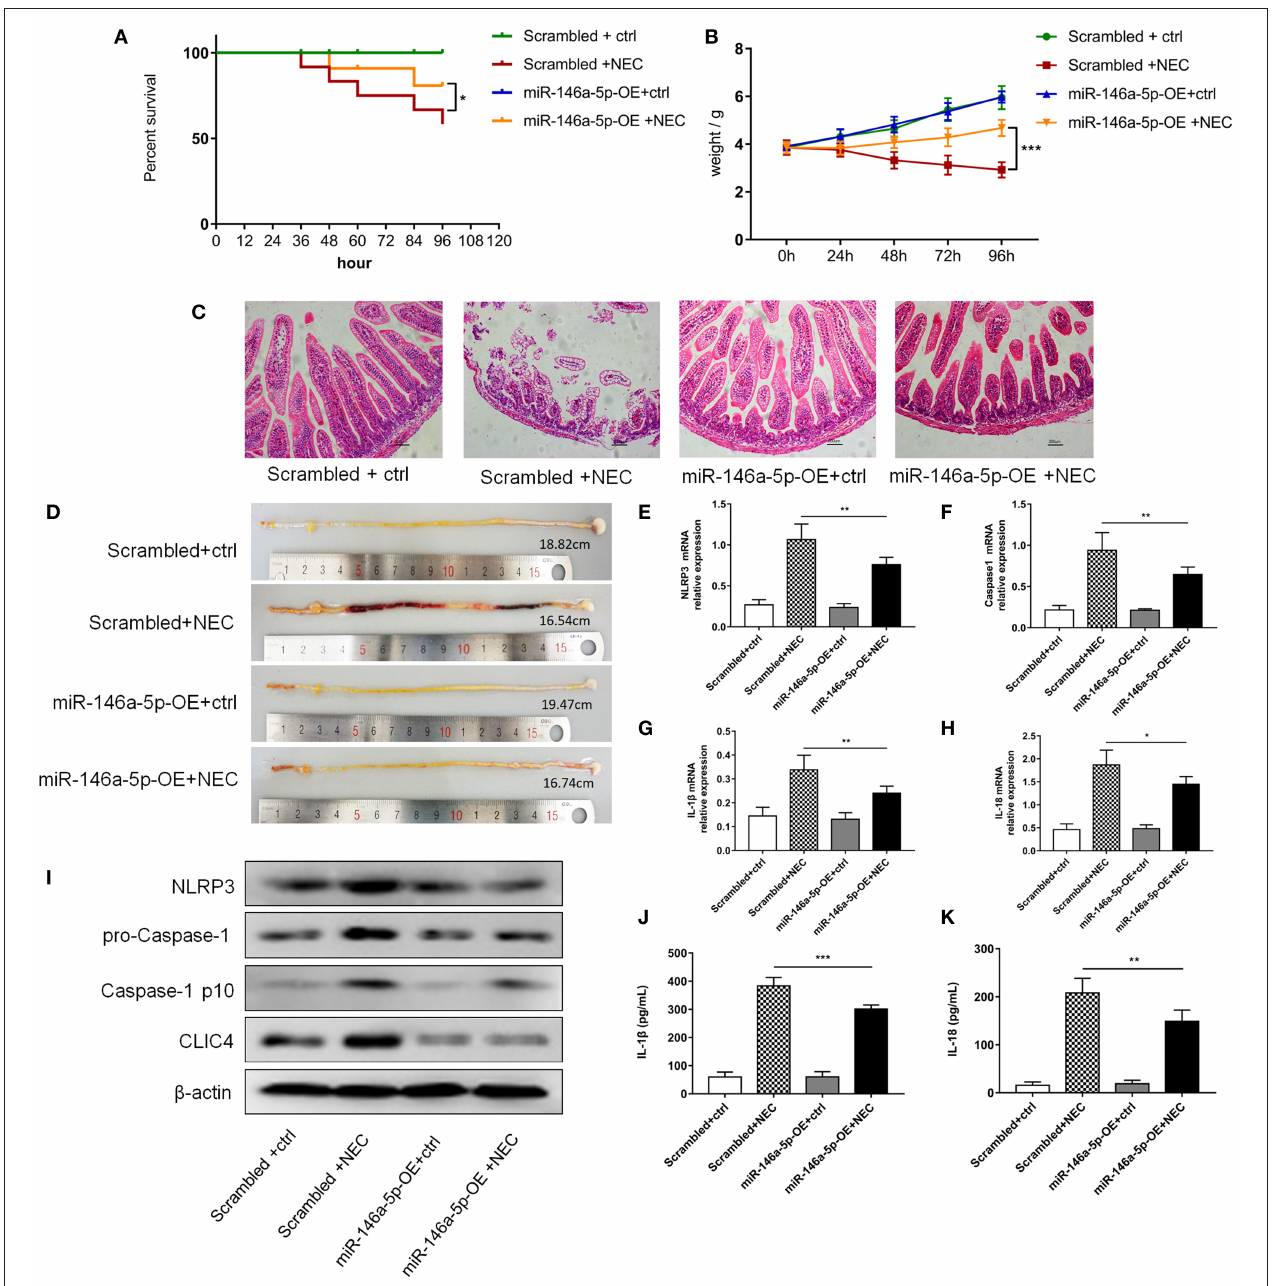
FIGURE 7 | MiR-146a-5p overexpression adenovirus’ effect on the activation of NLRP3 inflammasome and NEC mice. (A) Kaplan-Meier survival analysis of control and NEC mice after transduction with miR-146a-5p scrambled or overexpression adenovirus ( n = 12 per group). (B) Body weight of control and NEC mice after miR-146a-5p scrambled or overexpression adenovirus transduction ( n = 12 per group). (C) Representative pictures of HE in intestinal samples of control and NEC mice after transduction with miR-146a-5p scrambled or overexpression adenovirus. (D) Representative pictures of intestinal samples of control and NEC mice after miR-146a-5p scrambled or overexpression adenovirus transduction. (E–H) mRNA expression levels of NLRP3, Caspase-1, IL-1 β , and IL-18 in intestinal samples of control and NEC mice after transduction with miR-146a-5p scrambled or overexpression adenovirus ( n = 5 per group). (I) NLRP3, pro-Caspase-1, and Caspase-1 p10 protein expression levels in intestinal samples of control and NEC mice after transduction with miR-146a-5p scrambled or overexpression adenovirus. β -actin was re-used as the control image. (J,K) ELISA showing the IL-1 β and IL-18 expression levels in intestinal samples of control and NEC mice after miR-146a-5p scrambled overexpression adenovirus transduction ( n = 5 per group). Scrambled + ctrl, miR-146a-5p scrambled sequence adenovirus + control mice; Scrambled + NEC, miR-146a-5p scrambled sequence adenovirus + NEC mice; miR-146a-5p-OE + ctrl, miR-146a-5p overexpression adenovirus + control mice; miR-146a-5p-OE + NEC, miR-146a-5p overexpression adenovirus + NEC mice. * P < 0.05, ** P < 0.01, *** P < 0.001.